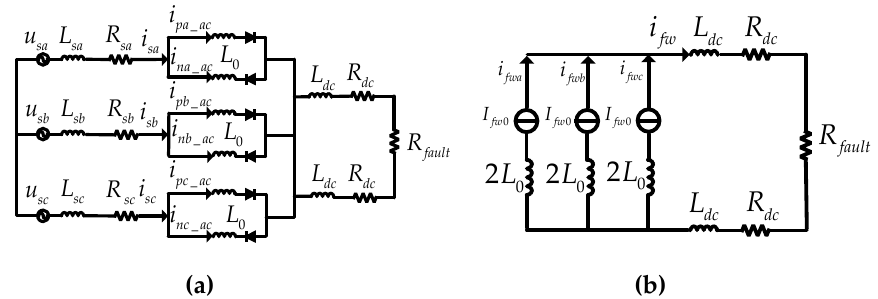
Figure 7. Equivalent circuit of the ( a ) AC feeding current and ( b ) freewheeling DC current. The fault current circuit after completely discharging IGBT blocks or capacitor to 𝑉 (cid:3030)(cid:3042)(cid:3041)(cid:3049) = 0 is